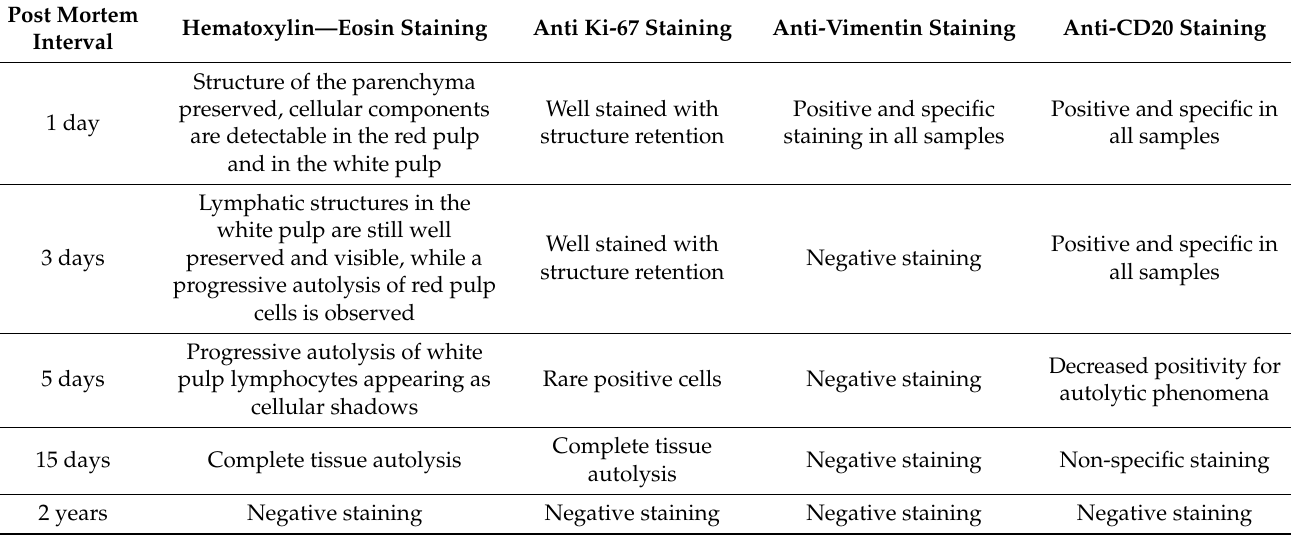
Table 4. Immunohistochemical evaluation of ki67, vimentin, and CD20 in spleen tissues.